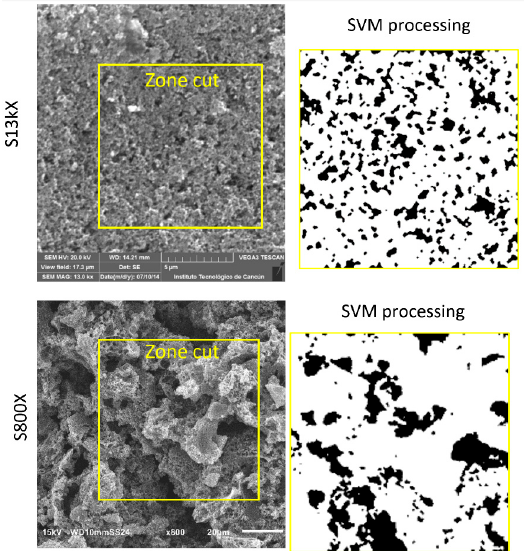
Figure 3. The binarization process using support vector machines (SVM) of the SEM samples of electrodes of a polymer electrolyte fuel cell (PEFC) (S13kX and S800X). The zone cut is the selected zone that is representative of the